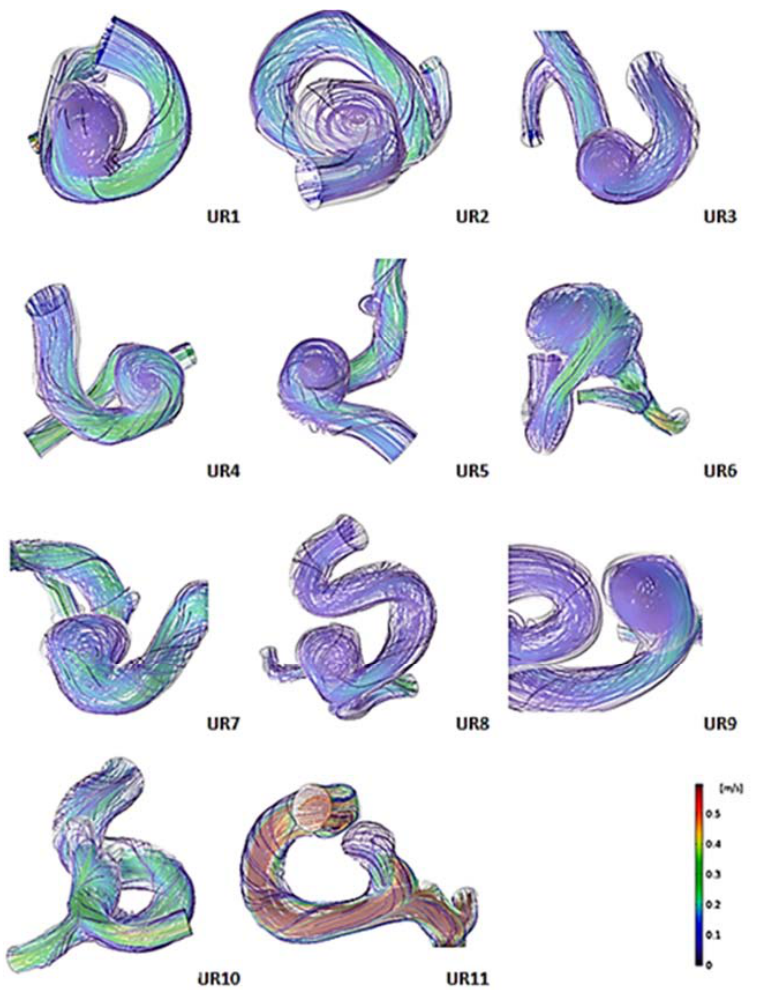
Figure 3. Simulated flow streamlines of unruptured aneurysms showing flow complexity at end ‐ diastole. UR: unruptured aneurysm.